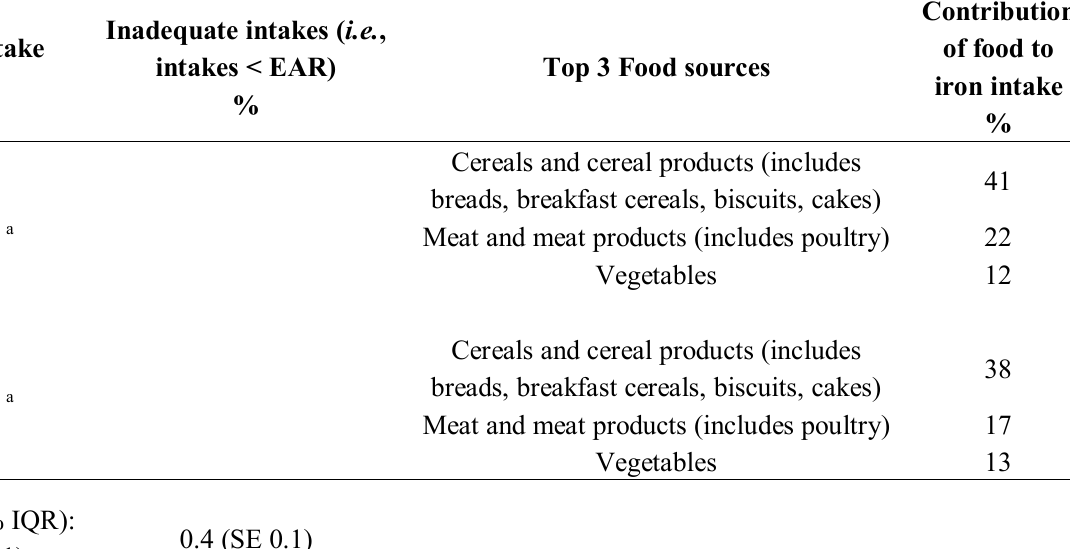
Table 2. Intakes, adequacy, and top food sources of dietary iron in economically-developed